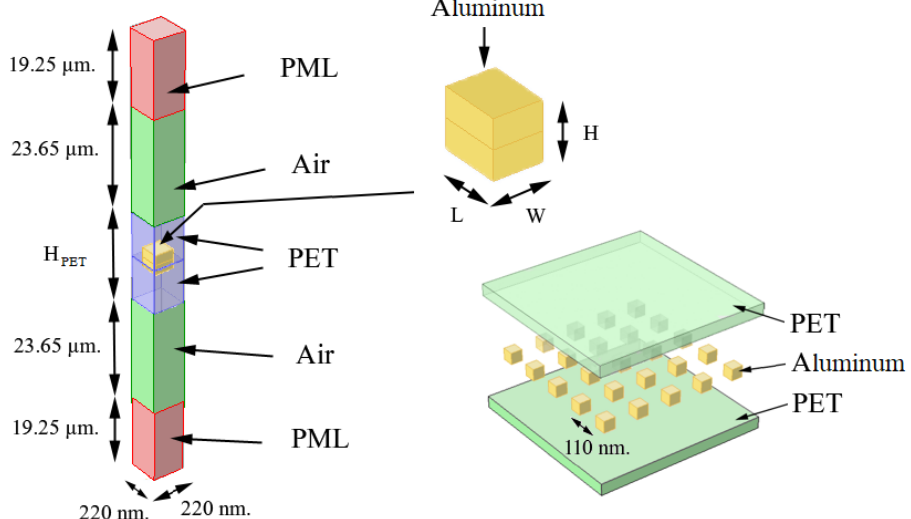
Figure 1. Proposed metachrosisable nano-film.